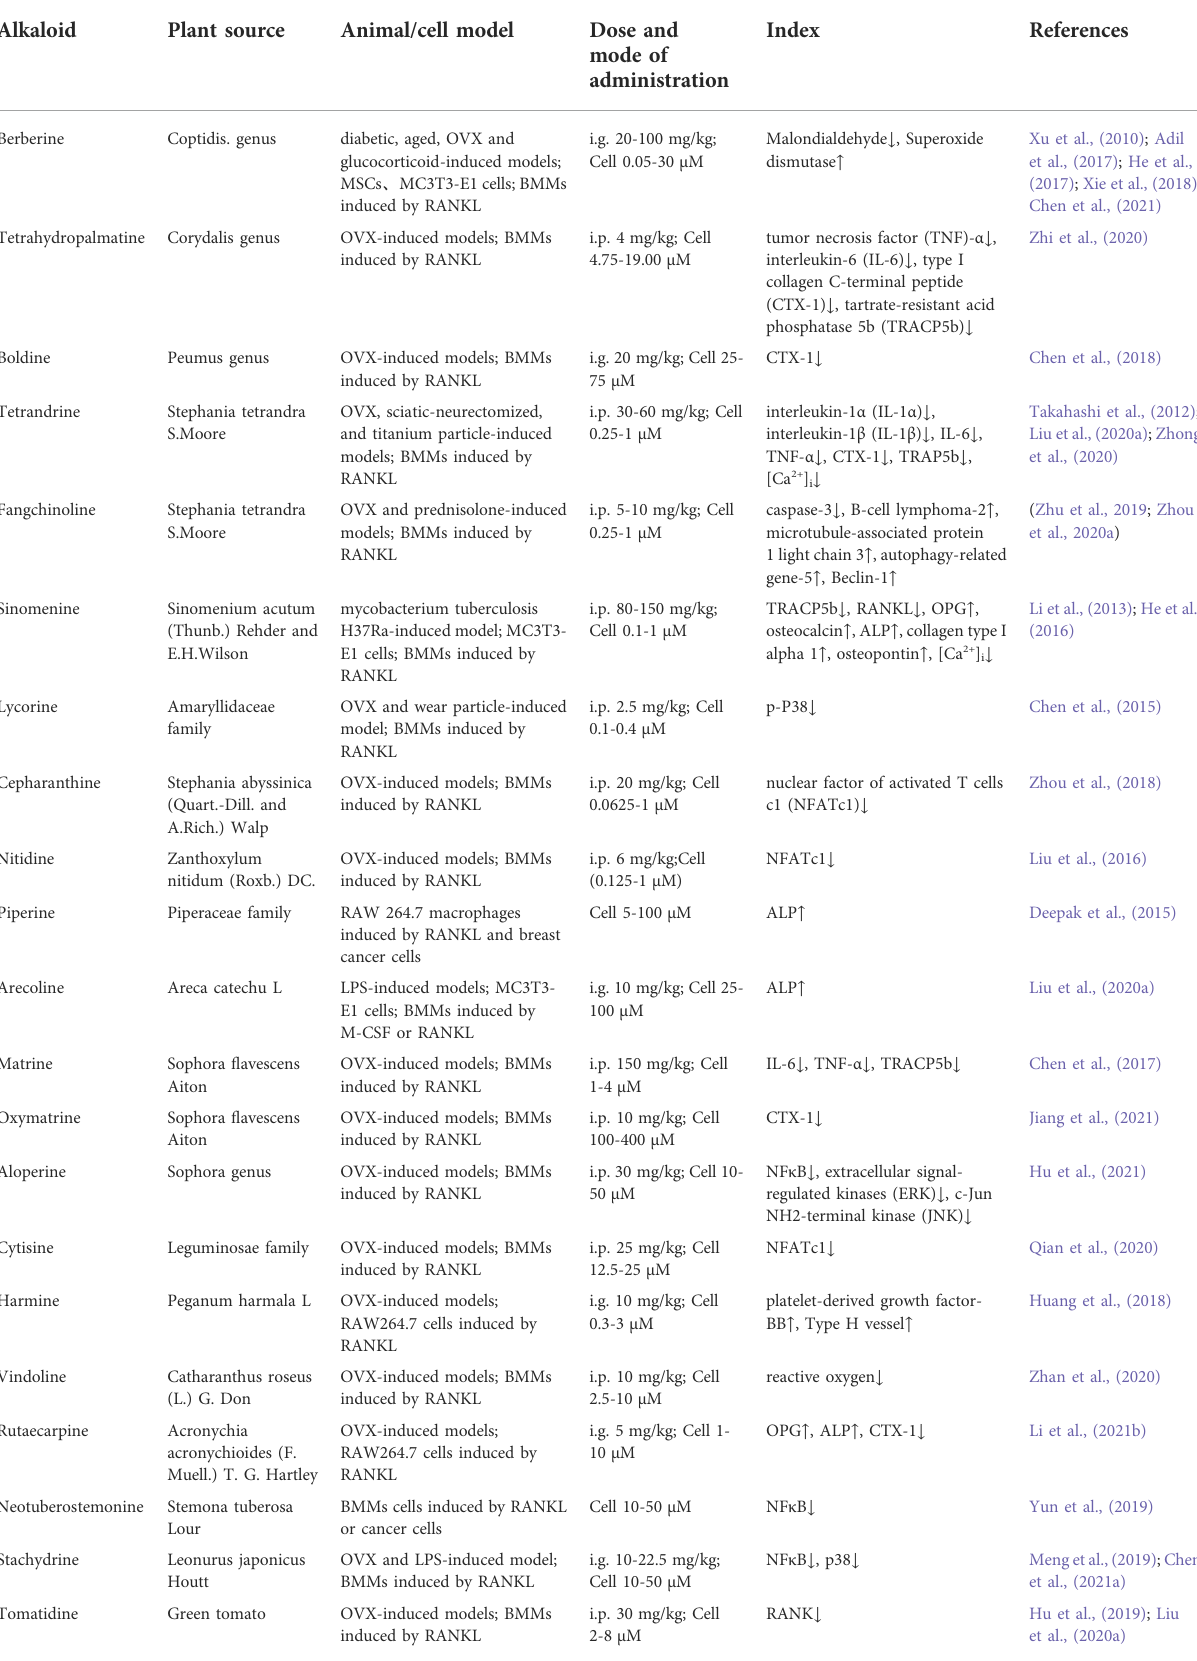
TABLE 1 Applications of natural alkaloids in the osteoporosis treatments.